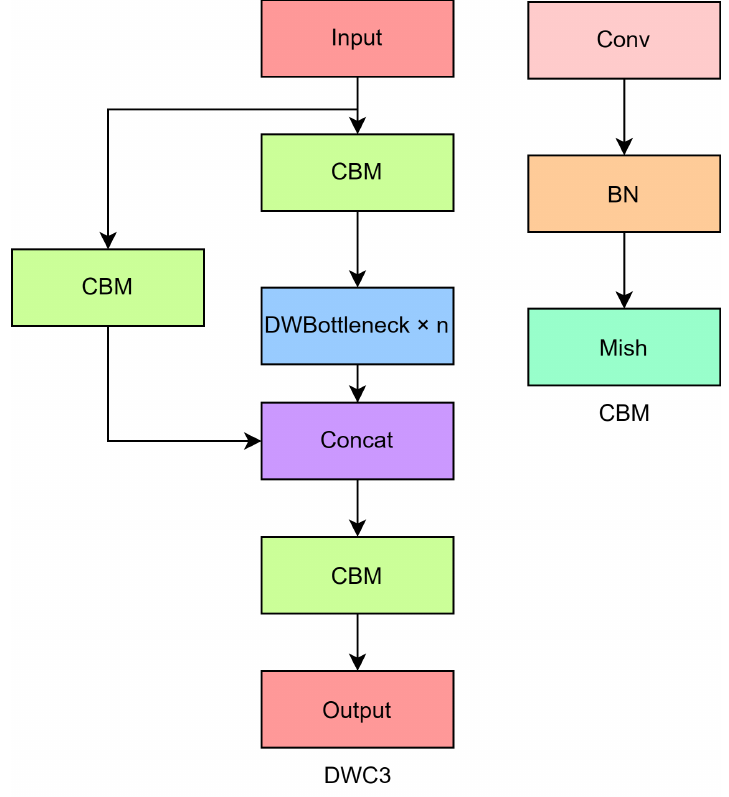
Figure 2. DWC3 module containing DWBottleneck.